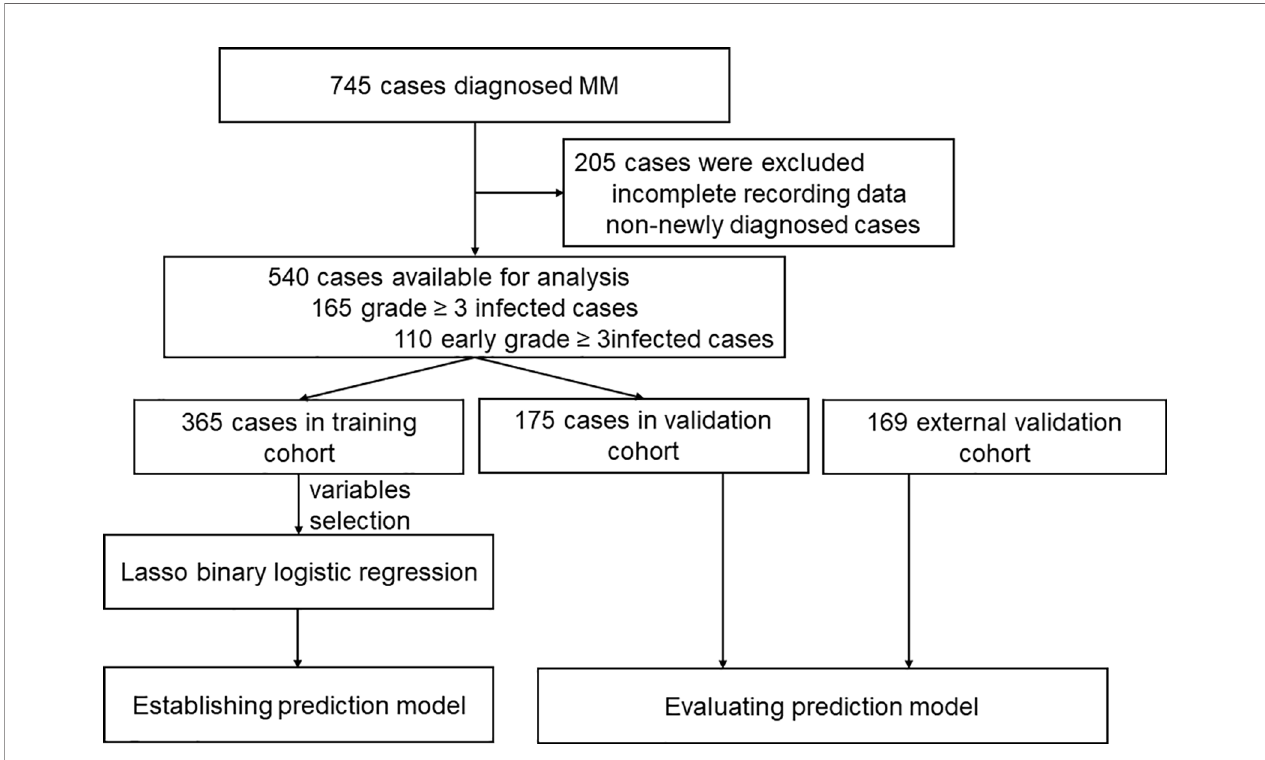
FIGURE 1 | The fl ow chart of analysis in this